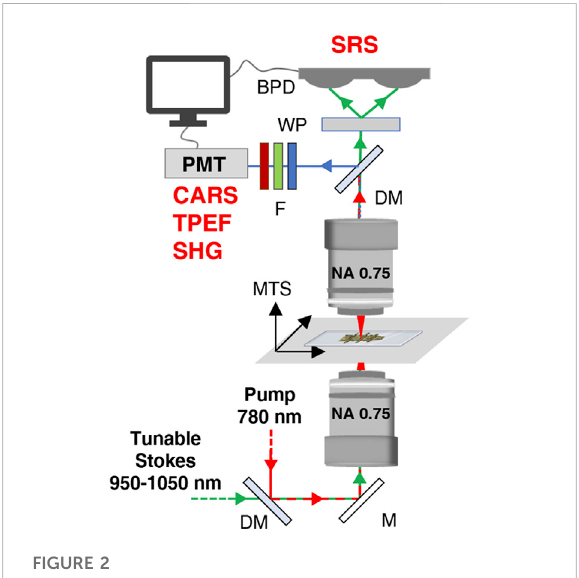
FIGURE 2 Schematic representation of the microscope setup. DM, dichroic mirror; M, mirror; MTS, motorized translation stage; F, fi lter; WP, Wollaston prism; PMT, photomultiplier tube; BPD, balanced photodiode; NA, numerical